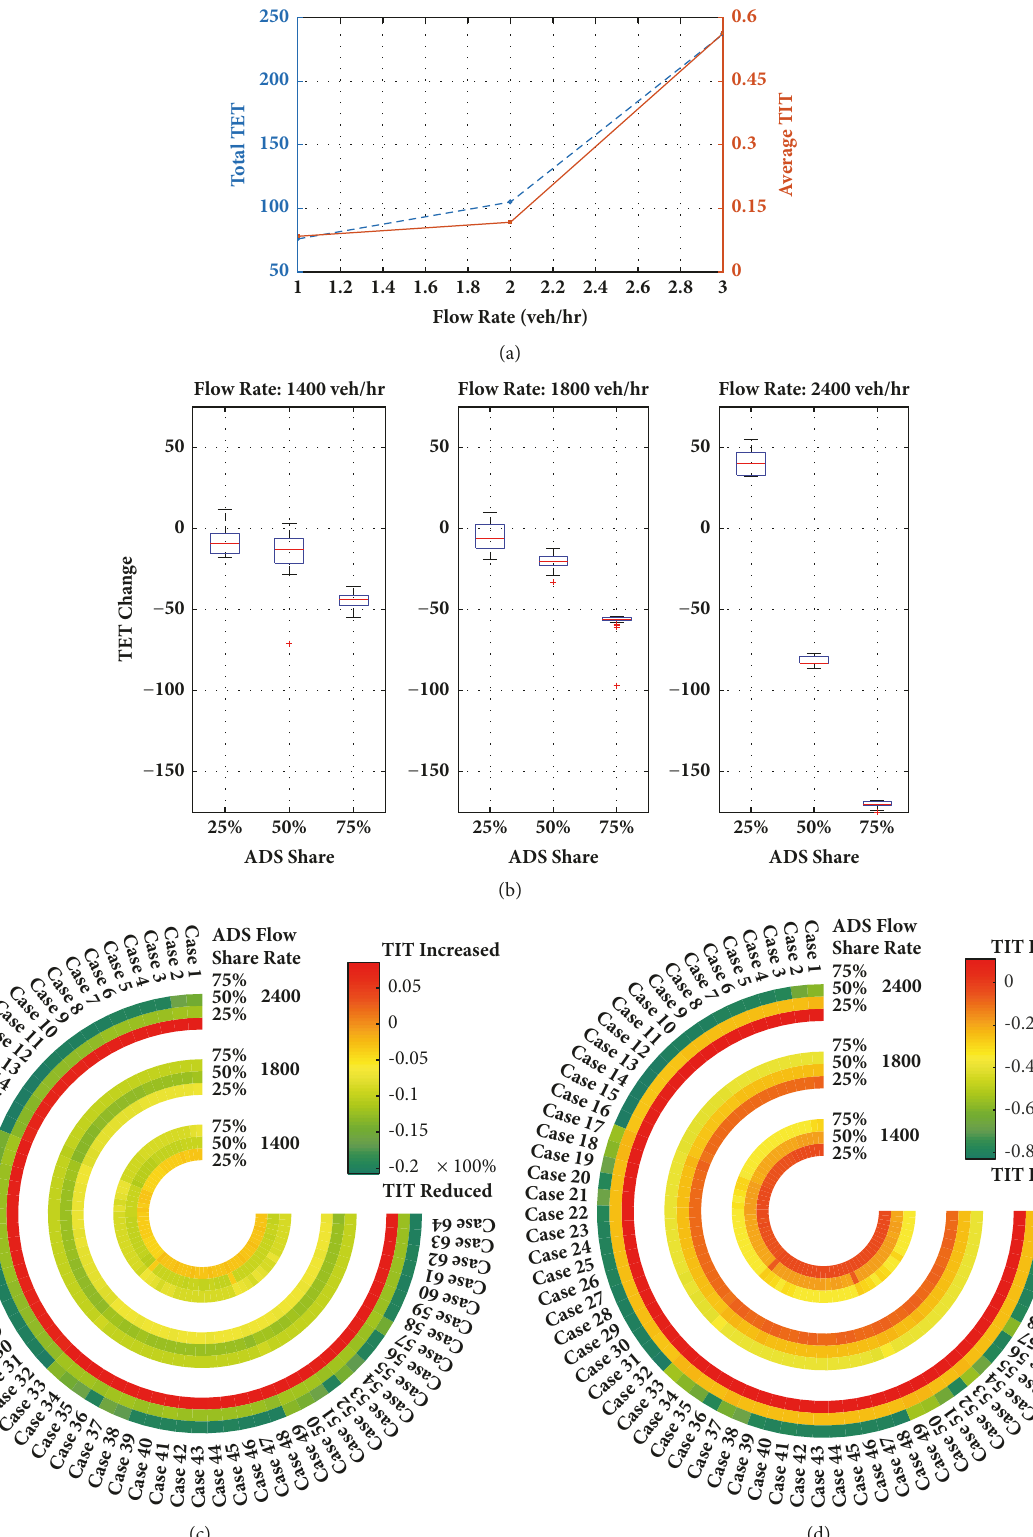
Figure 4: (a)Base-casesafety parametervaluesatvarying flowrates.(b)Changes intotal TET,(c)variations of averageTIT valuesconsidering MDS vehicles only, and (d) variations of average TIT values considering all vehicles, due to varying platoon configurations at different flow rates and ADS